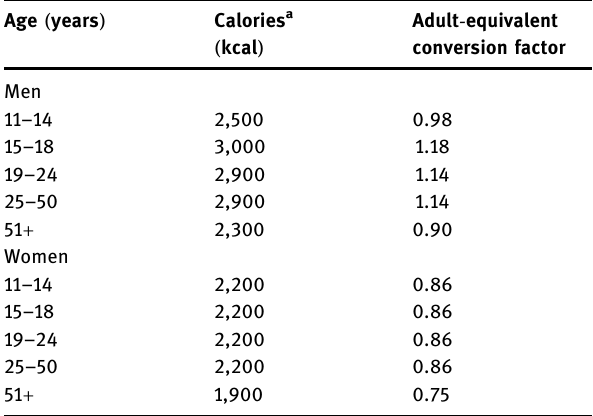
Table 1: Adult equivalent reference scale giving age and gender of farmers